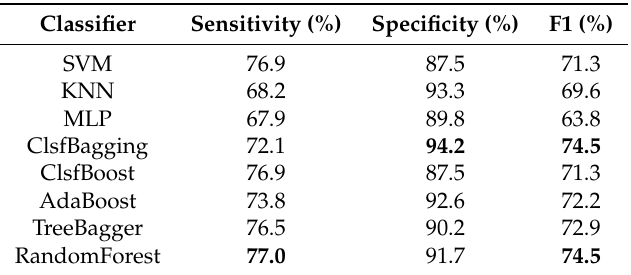
Table 5. Performance of classifiers in patient independent models using the original imbalanced dataset and equal cost of misclassification (Results show average performance of all seven participants). The bold values show the highest performance among all the